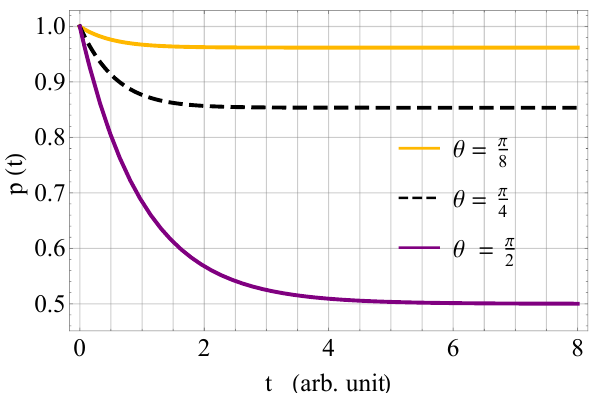
Figure 1. Plots of p ( t ) according to (17) for three values of θ . Other parameters: γ = 1 (arb.